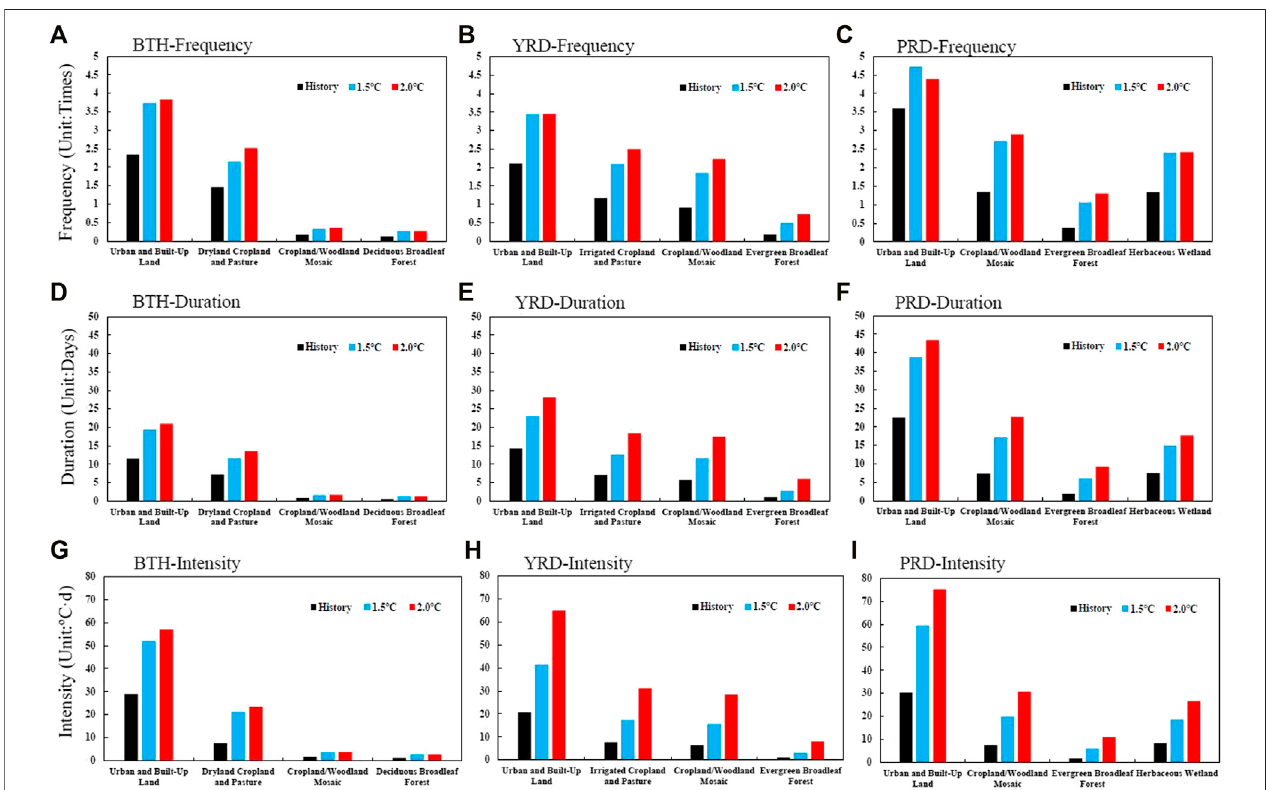
FIGURE 9 | Area averages of HW frequency (A) , (B) , (C) , duration (D) , (E) , (F) and intensity (G) , (H) , (I) over four major underlying surfaces in each urban agglomeration (black represents the historical period, blue represents the 1.5 ° C warming period and red represents the 2.0 ° C warming period).